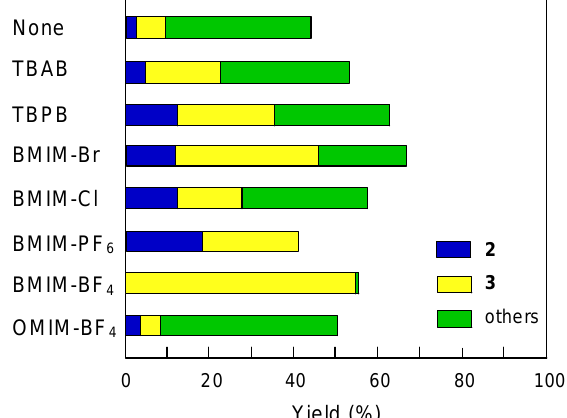
Figure 1. Reaction of CO with 2-aminoethanol in the presence of various ionic liquids. Reaction 2 conditions: 2-aminoethanol, 60 mmol; CO 10 MPa; ethanol, 4 cm 3 ; ionic liquid, 11.4 mmol; 2 temperature, 150°C; time, 6